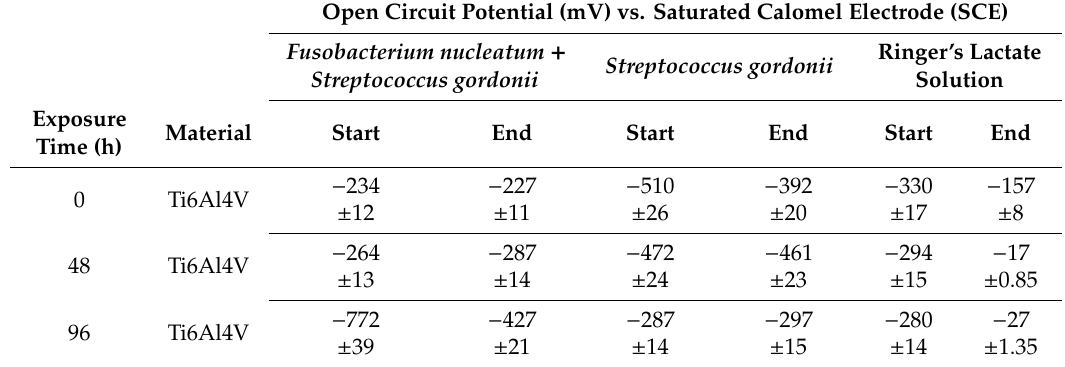
Table 3. Open circuit potential values of Ti6Al4V alloy at 37 ◦ C.